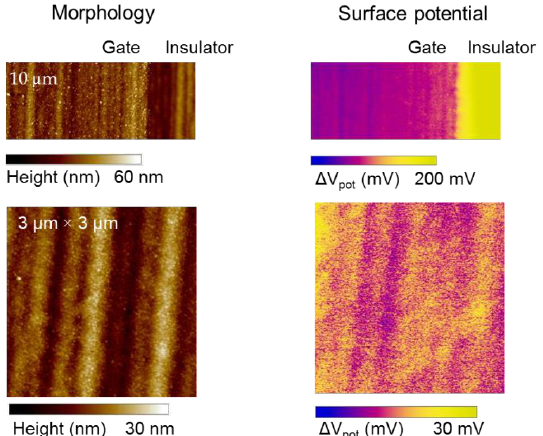
Figure 12. Surface morphology and surface potential of the Ir gate before (top figures) and after (bottom figures) 2week exposure to VOCs at high temperature. It is worth pointing out that the sensing layer is not degraded upon long-term exposure to elevated tempera- tures and repeated VOC adsorption/desorption, which is extremely important for our target application (air quality